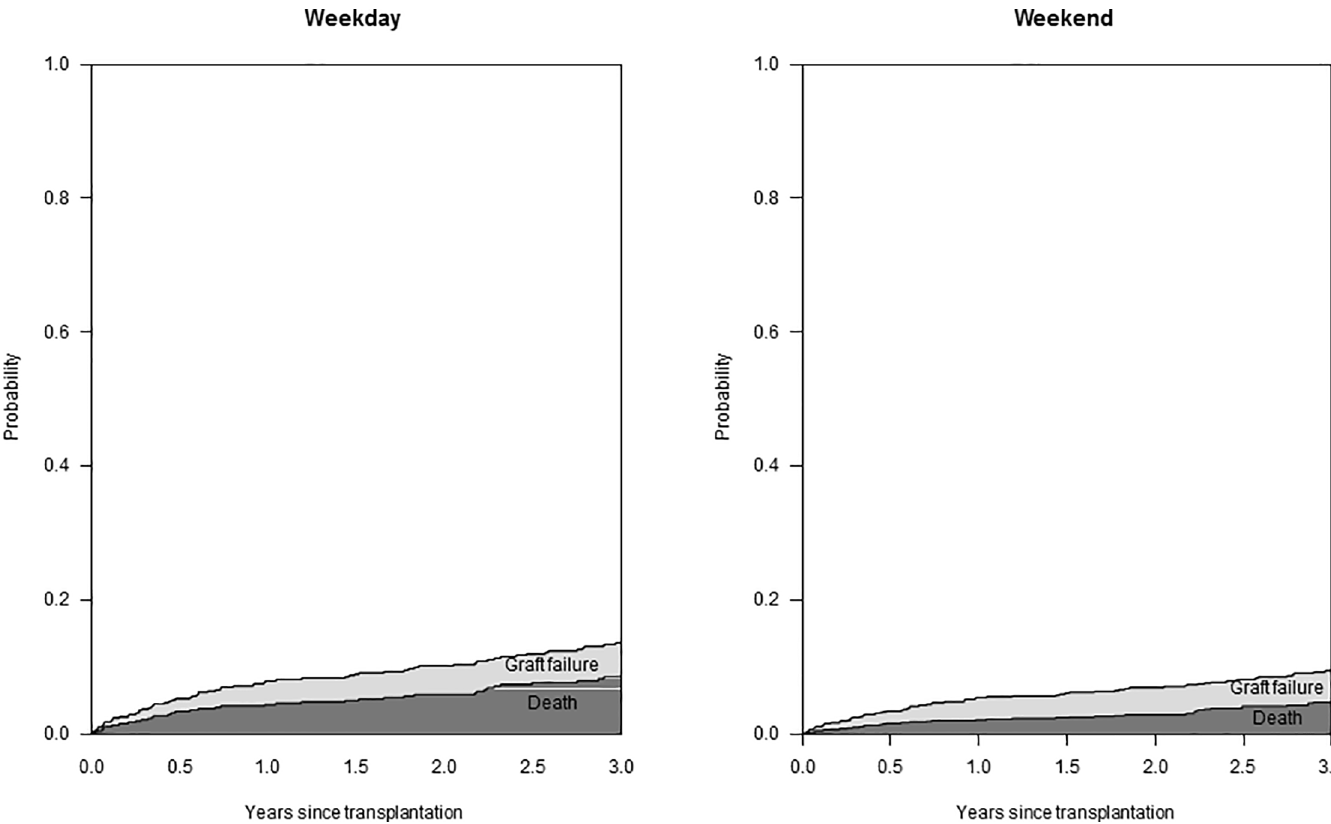
Fig 2. Transition probabilities by weekend transplant status derived from an illness-death model with initial state “renal transplantation (RTx)”, transient state “graft failure” and absorbing state “death (from any cause)”.